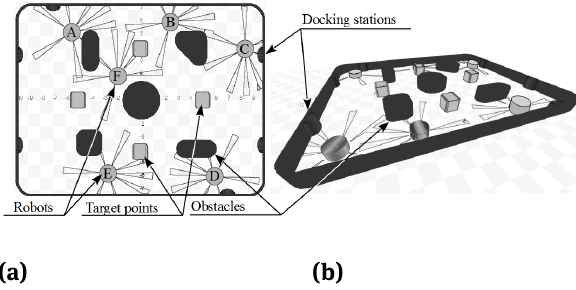
Figure 9: Simulation environment visualization: (a) – 2D, (b) – 3D.